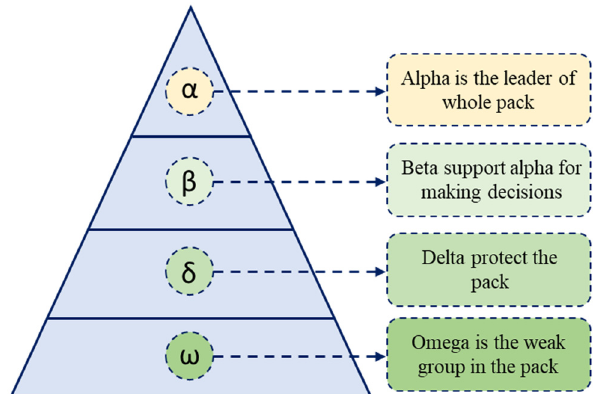
Figure 4: A hierarchy of dominance among gray wolves within a pack [ 26 ] .